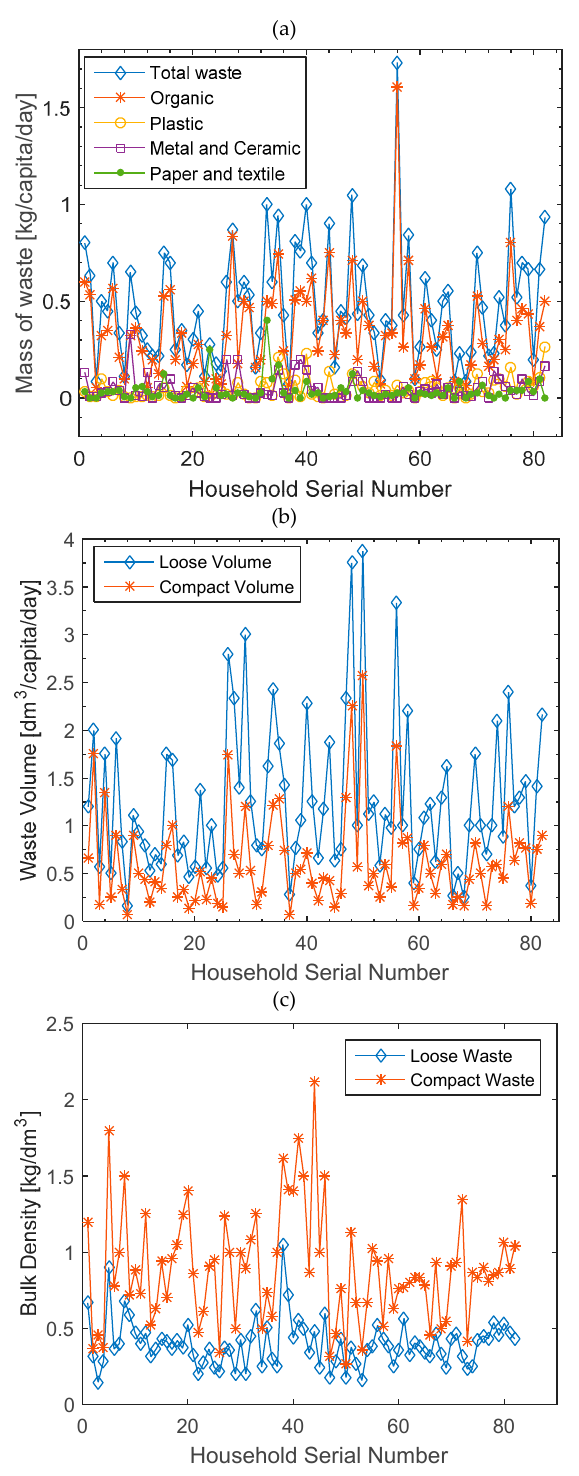
Figure 2. Results of first day sampling. ( a ) Mass of the total and constituent wastes, ( b ) loose and compact volume, and ( c ) bulk densities for loose and compact wastes. Statistically similar results are generated for the other 9